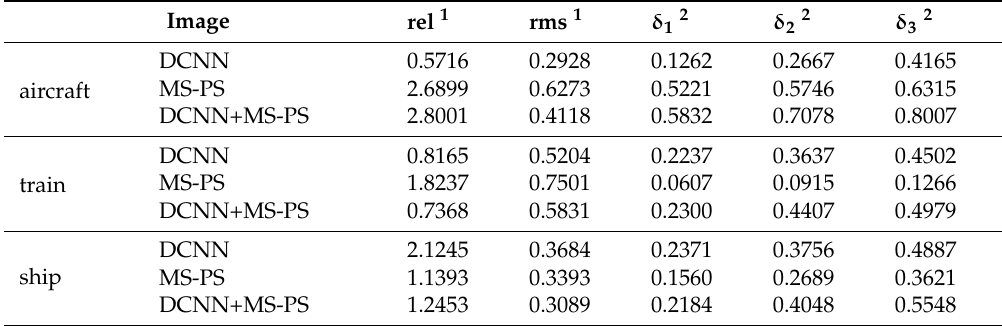
Table 3. The quantitative analysis of the results of Figure 7. MS-PS is an acronym for multi-spectral photometric stereo, and the parameter ‘rel’ and ‘rms’ are defined in Equations (7) and (8). Image rel 1 rms 1 δ 1 2 δ 2 2 δ 3 2 DCNN 0.5716 0.2928 aircraft